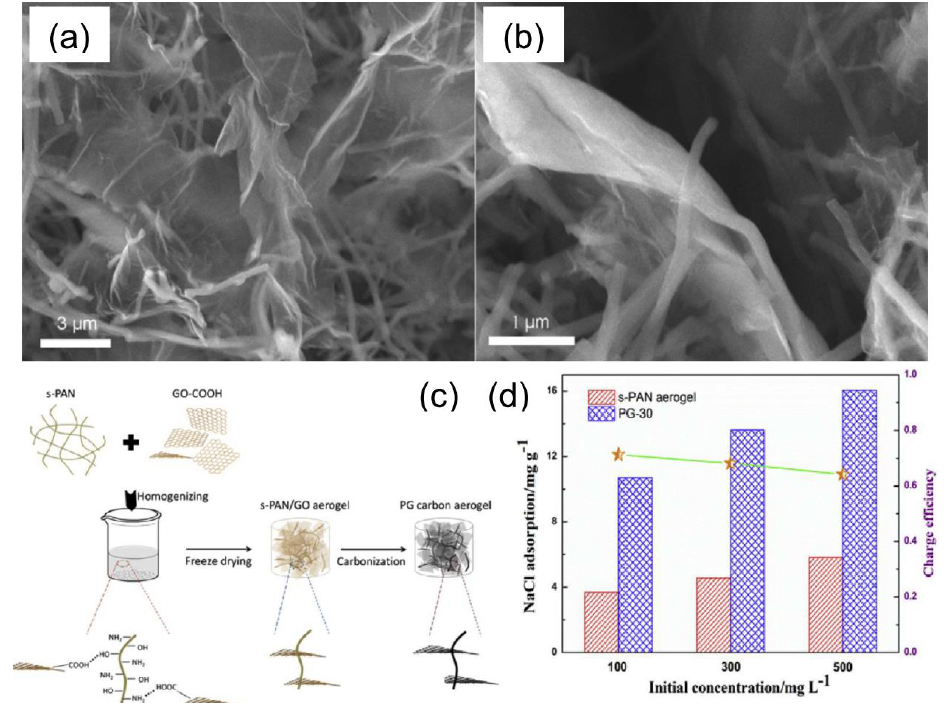
Figure 26. ( a , b ) Low- and high-magnification SEM images of PG-30 carbon aerogel with 30 wt% graphene oxide (GO). ( c ) Schematic illustration for the preparation of s-PAN/GO aerogel and PG carbon aerogel. ( d ) NaCl adsorption capacities of s-PAN aerogel and PG-30 electrodes in NaCl solution with different initial concentrations (reproduced from reference [211] with permission. Copyright 2017,